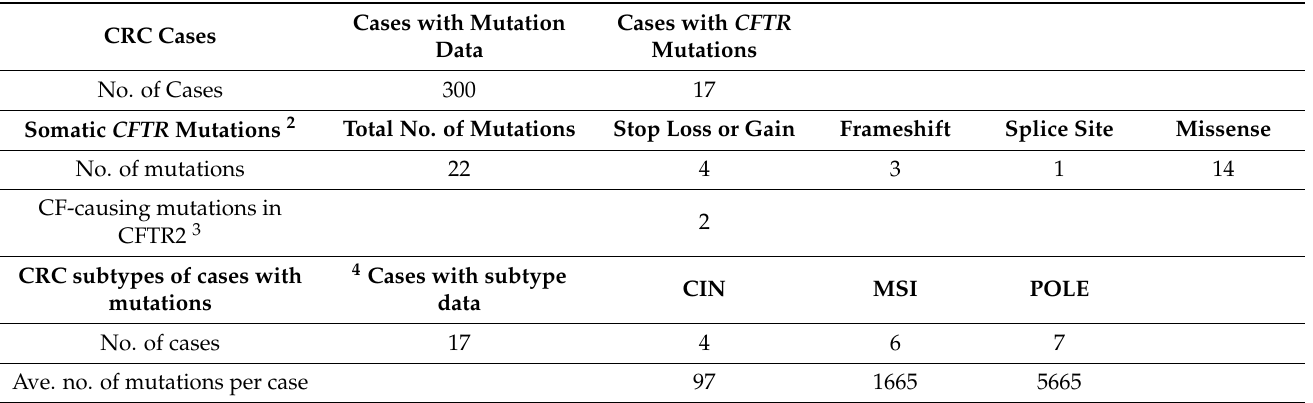
Table 4. Somatic mutations in the CFTR gene in the TCGA COADREAD dataset